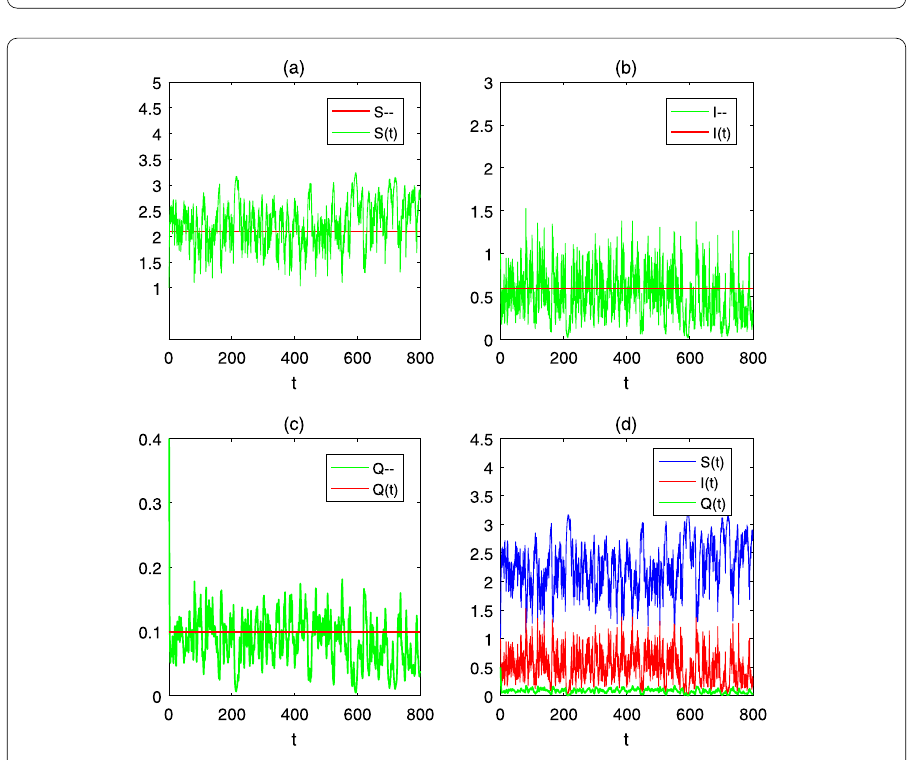
Figure 6 The oscillation behavior of system (3) near the endemic equilibrium point, u = 0.4, δ = 0.15, β = 0.5, b = 0.1, q = 0.3, ε = 0.35, α 2 = 0.25, α 3 = 0.15, γ = 0.2, m = 0.01, n = 0.1, A = 1, σ = 0.2, where R 0 = 1.6628 > 1, (cid:23) R = 1.4482 >